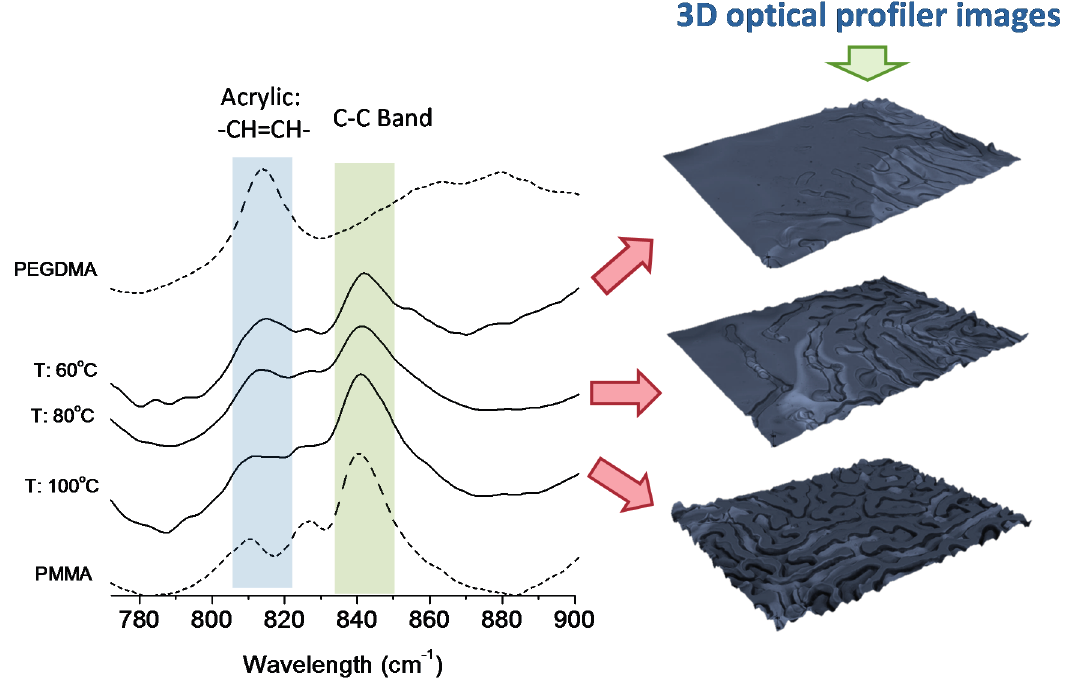
Figure 2. FTIR-ATR spectra of the crosslinked films obtained by simultaneous heating and UV irradiation of the monomer mixture and the resulting 3D images of the surface patterns formed by photocrosslinking. The photosensitive mixture employed was MMA/EGDMA (85/15) v / v % and 2 wt% of IRG 651. The irradiation experiments were carried out at three different temperatures: 60, 80 and 100 °C, using a spacer of 50 μ